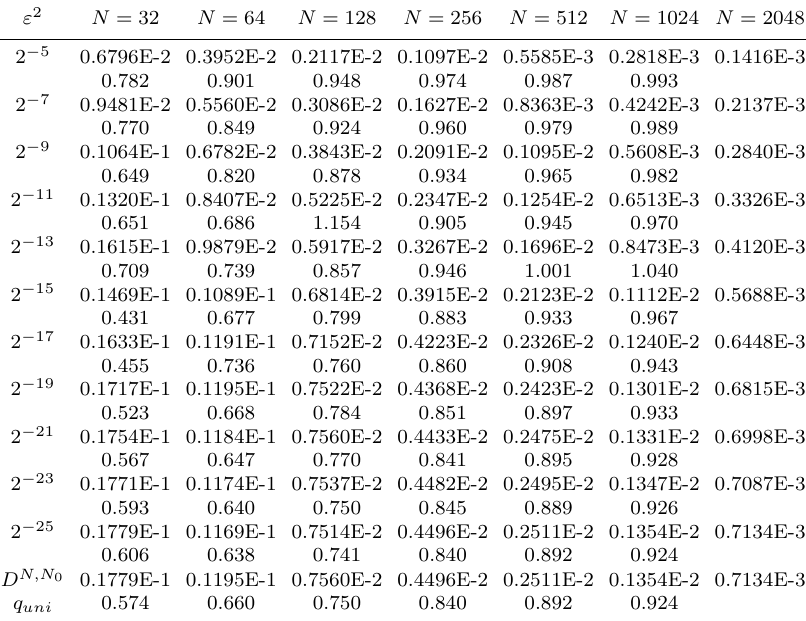
Table 3. Maximum errors and ε -uniform orders of convergence on the Shishkin mesh for problem (4.1), (4.2) with m = 1 / 5 ε